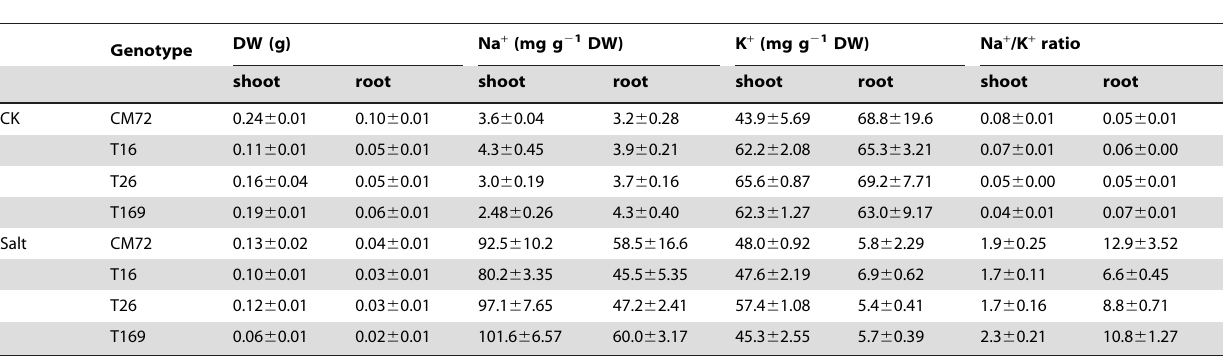
Table 4. Dry weight (shoot, root and whole-plant), Na + and K + contents and the Na + /K + ratios in CM72 and three Tibetan barleys.